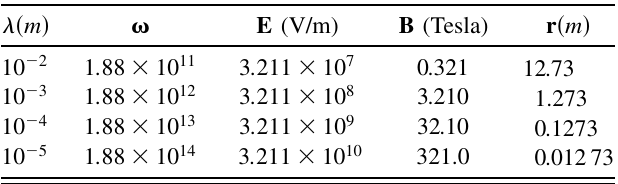
TABLE I. Parameters comparison for maximum proton